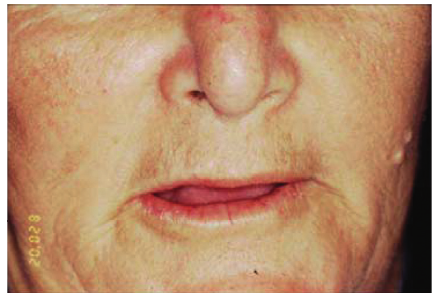
Figure 1: Defect in the nasal wing.